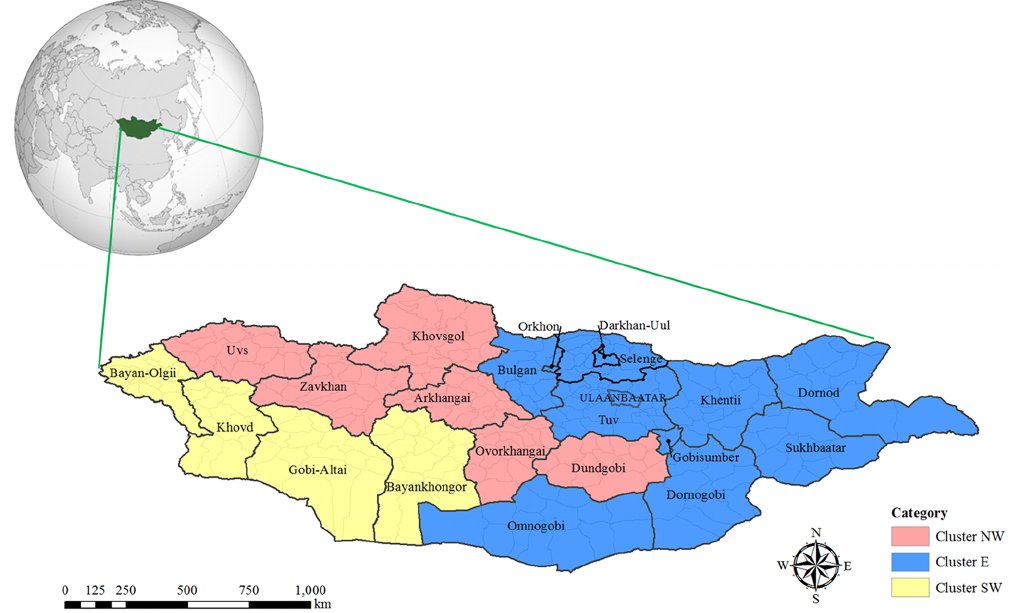
Figure 2. Spatial clusters of the mortality index based on 1972–2010 soum level mortality indices. Source: Lall et al (2016); https://en. wikipedia.org/wiki/File:Mongolia_(orthographic_projection).svg (last access: 19 June